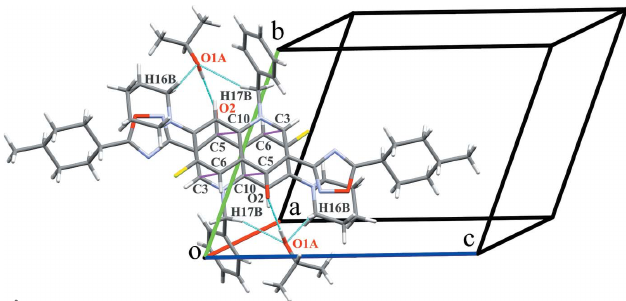
Figure 2 Tetrameric building unit bonding: hydrogen bonds (in cyan) and short contacts (in magenta).